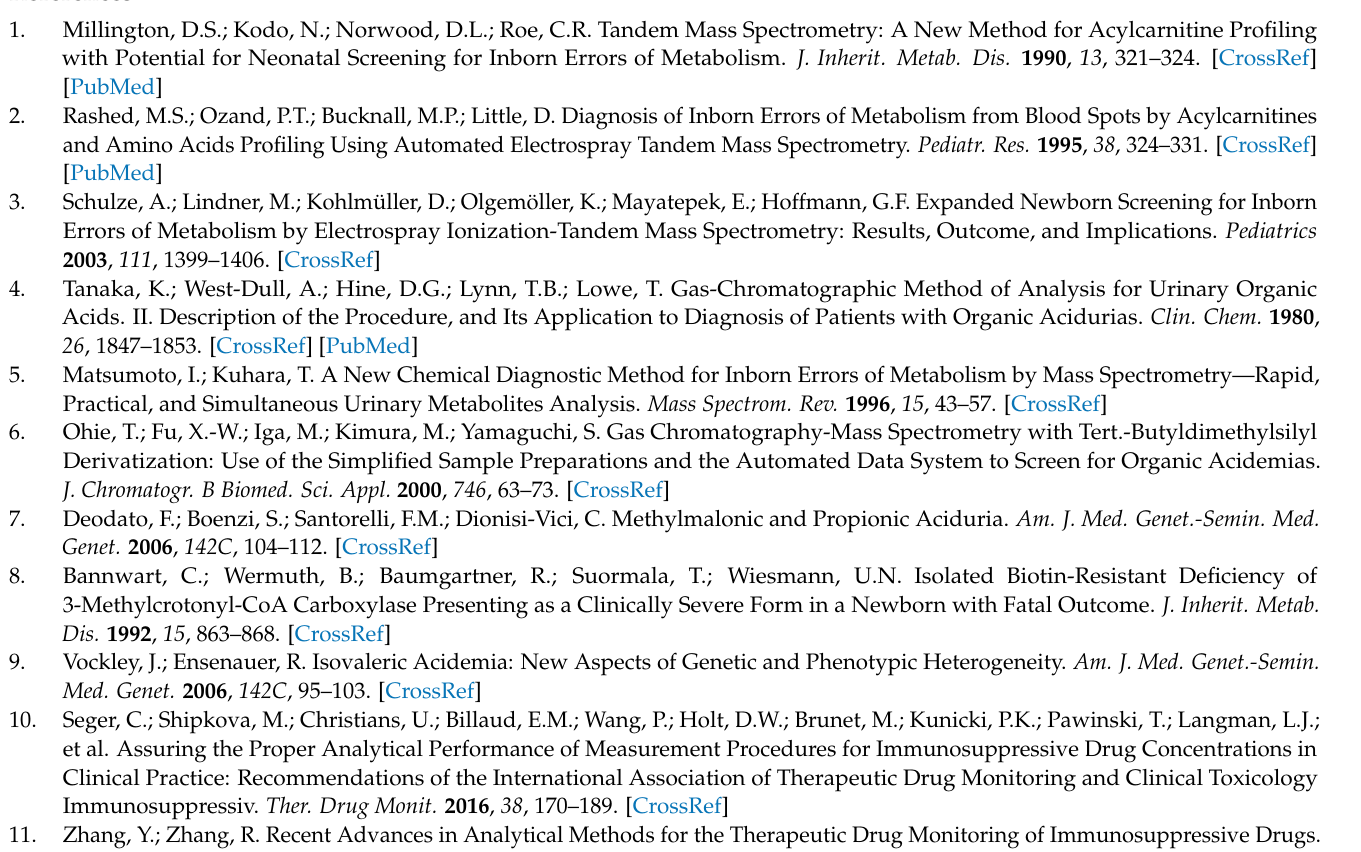
Table S2: Results of urine analysis by GC-MS at the time of